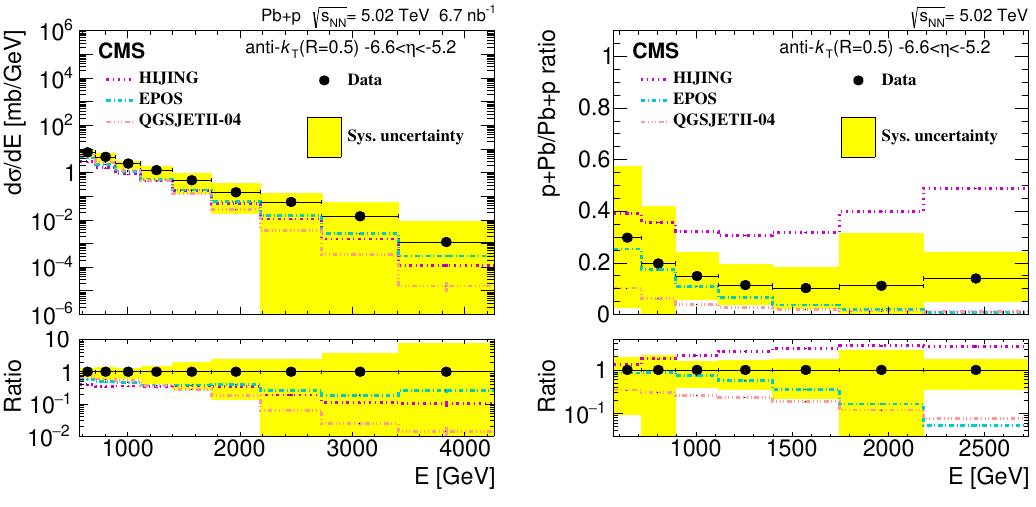
Figure 5 . Stable-particle-level di(cid:11)erential jet cross section as a function of jet energy in proton-lead collisions at 5.02 TeV. The Pb+p measurement is depicted left, and the ratio of the p+Pb to Pb+p cross sections is displayed right. The data are compared to model predictions from epos-lhc , hijing , and qgsjetii-04